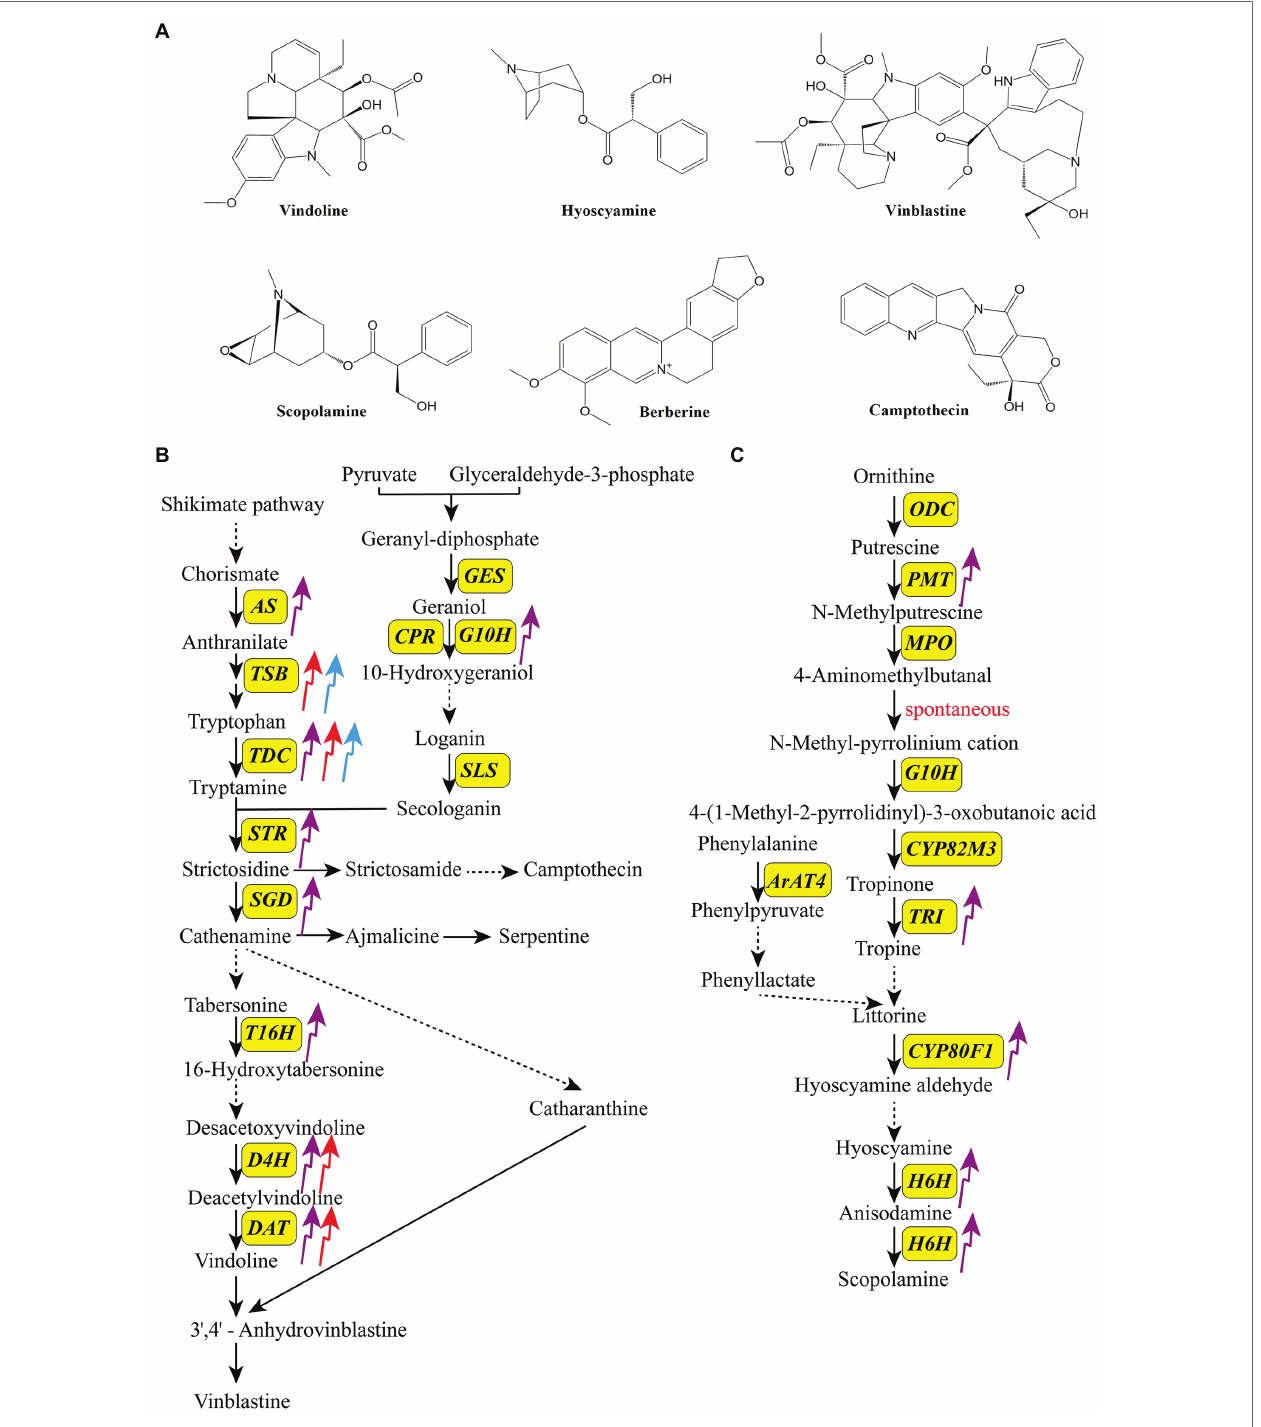
FIGURE 3 | Structures of some bioactive alkaloids in medicinal plants (A) and the effects of light quality on the transcripts of key enzyme genes in the biosynthetic pathways of monoterpenoid indole terpenoid alkaloids (B) and tropane alkaloids (C) . The upward arrows indicate upregulation and the downward arrows indicate downregulation. The purple arrow, red arrow, and blue arrow indicate UV-B, red light, and blue light, respectively. ArAT4 , aromatic amino acid aminotransferase 4; AS , anthranilate synthase; CPR , cytochrome P450 reductase; CYP80F1 , cytochrome P450 80F1; CYP80M3 , cytochrome P450 80 M3; DAT , 6-17-O-deacetylvindoline O-acetyltransferase; D4H , deacetoxyvindoline 4-hydroxylase; GES , geraniol synthase; H6H , hyoscyamine 6b-hydroxylase; G10H , geraniol-10-hydroxylase; MPO , N-methylputrescine oxidase; ODC , ornithine decarboxylase; PMT , putrescine N-methyltransferase; SGD , strictosidine β -glucosidase; SLS , secologanin synthase; STR , strictosidine synthase; TDC , tryptophan decarboxylase; TRI , tropinone reductase I; T16H , tabersonine